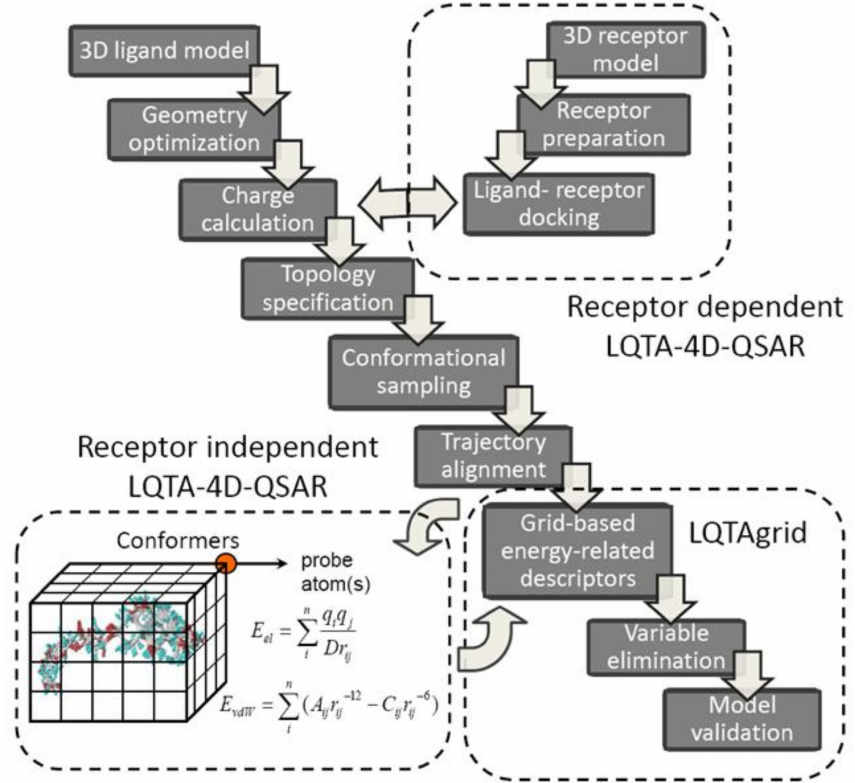
Figure 6. Flowchart of LQTA